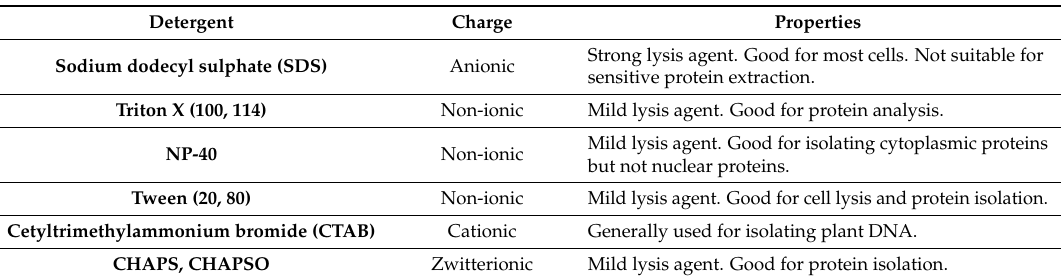
Table 2. List of some detergents and their properties. A comprehensive list of detergents can be found here